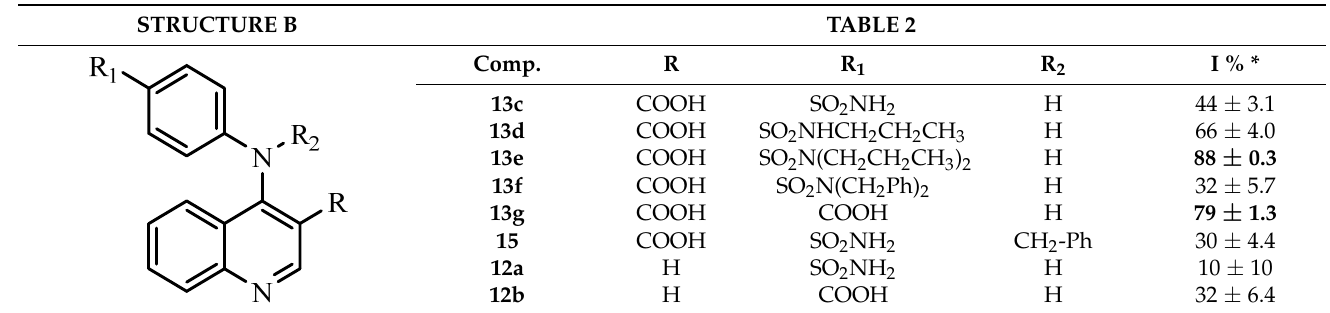
Table 2. Inhibition (%) values of compounds 13c–g, 12a,b and 15. STRUCTURE B TABLE 2